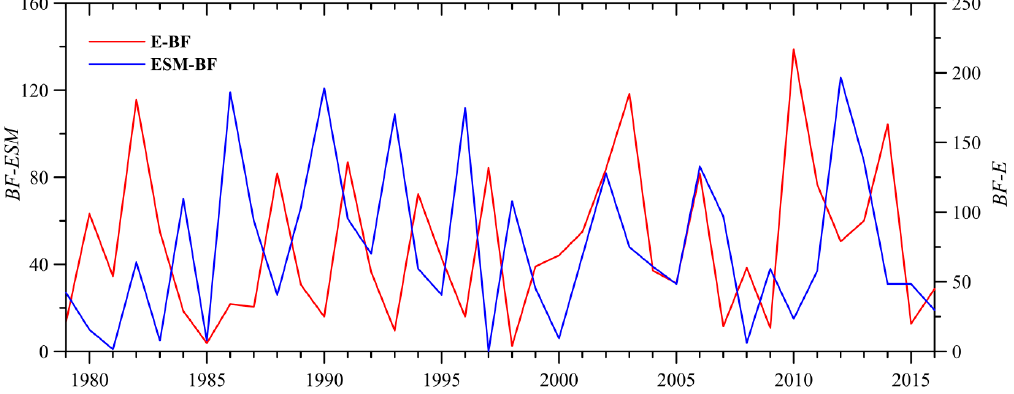
Figure 10. Interannual changes in E-BF and ESM-BF.